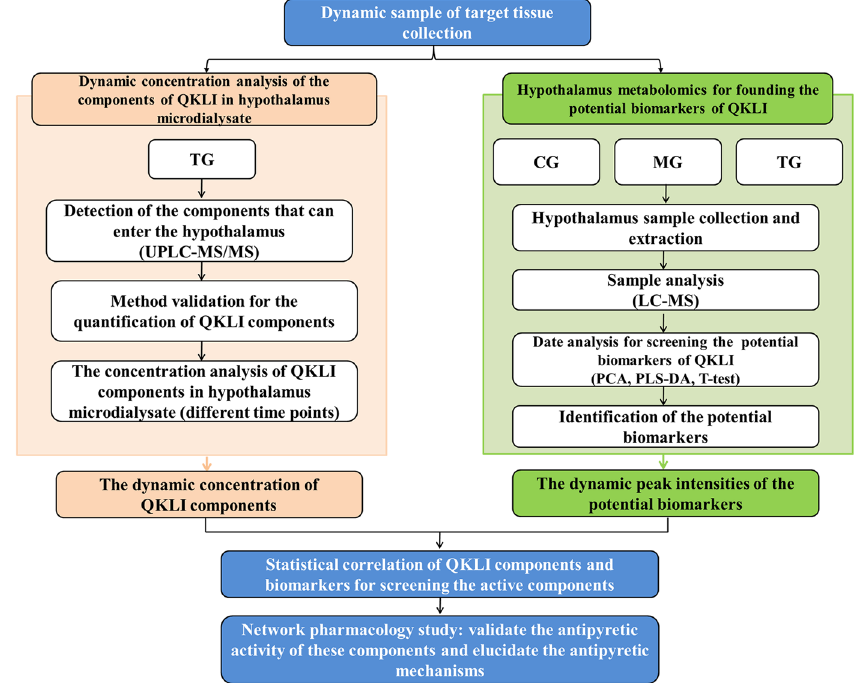
Figure 1. The flow diagram of identifying antipyretic components and mechanisms of QKLI by using target tissue metabolomics biomarkers as pharmacodynamic surrogate